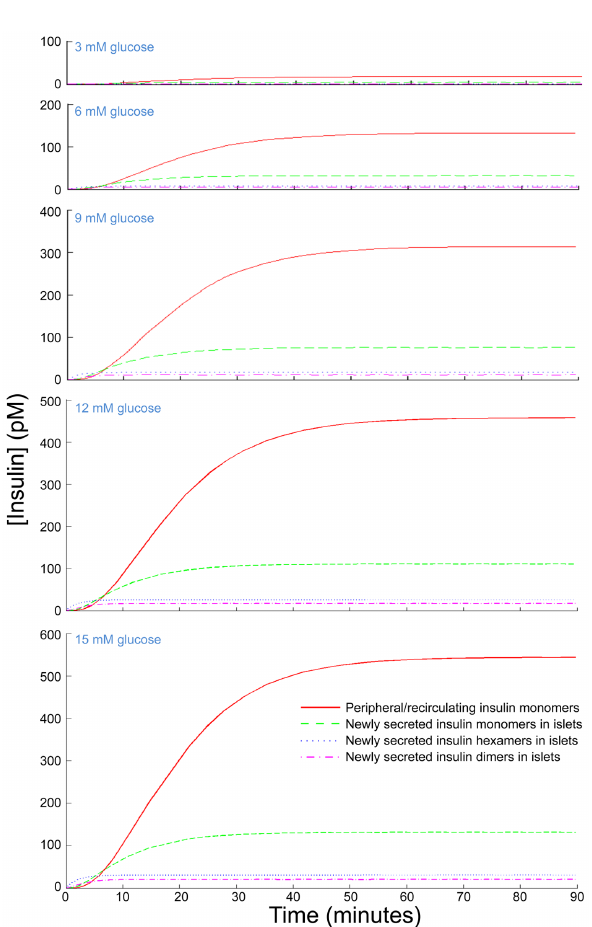
Glucose level (mM)